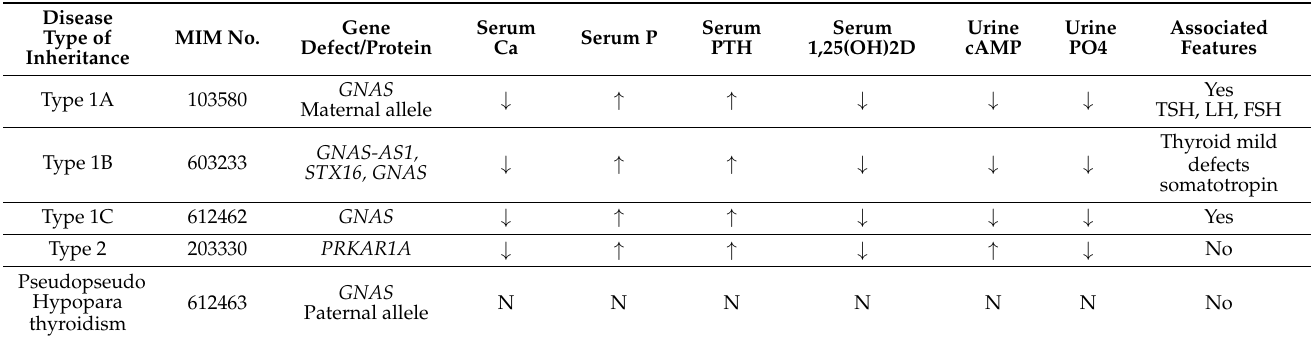
Table 4. Different subtypes of